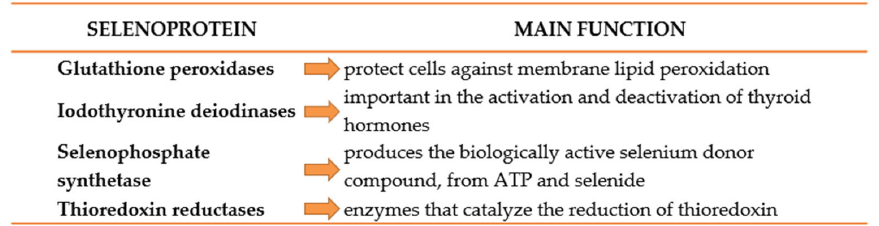
Figure 2. Main selenoprotein classes and their involvement in AD pathomechanism.